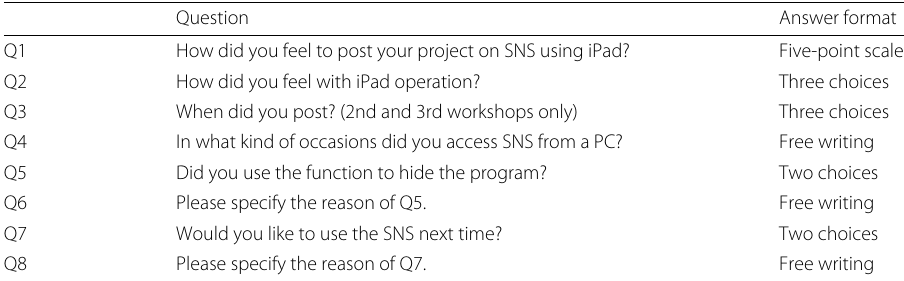
Table 2 Main items of the questionnaire